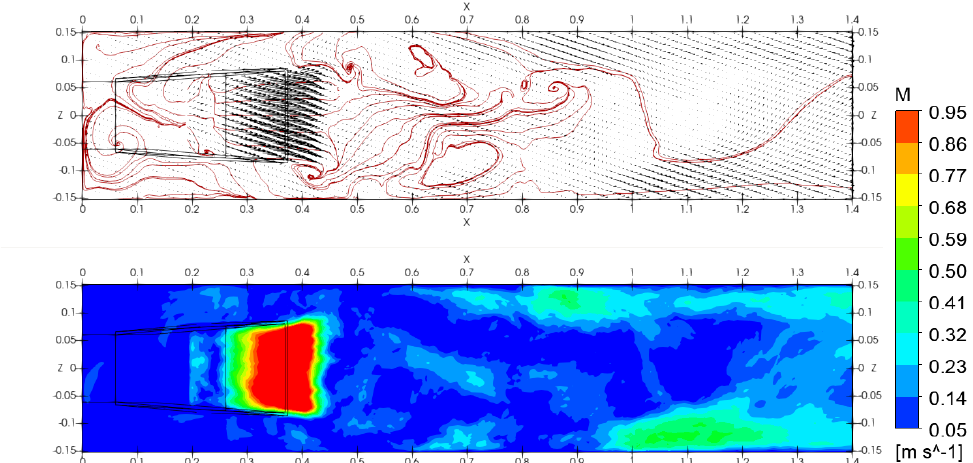
Figure 28. LBM, vector lines ( top ) and the magnitude of time-averaged 2D velocity ( bottom ) in horizontal plane ( y = 170mm ) .